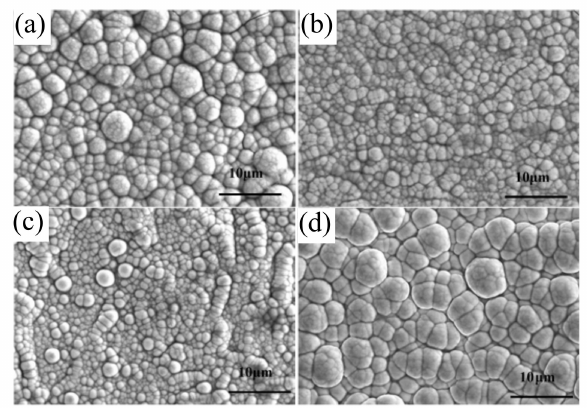
Figure 1. Scanning electron microscopy (SEM) images of the NiCrP alloy coatings at T = 30 ◦ C, D K = 15 A / dm 2 and 100 g / L of CrCl 3 · 6H 2 O with di ff erent pH values: ( a ) 3.0, ( b ) 3.5, ( c ) 4.0, and ( d )